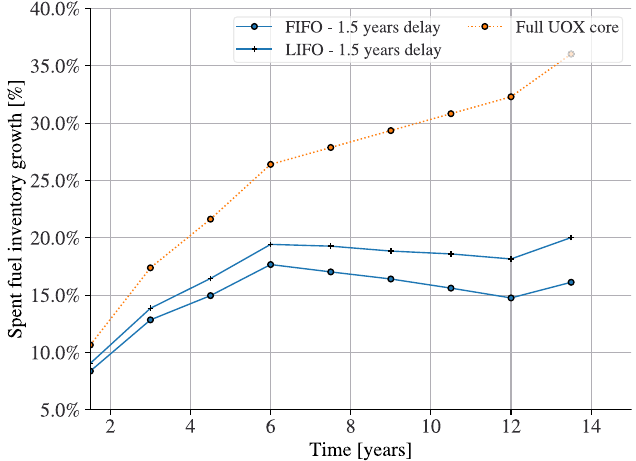
Fig. 11. On-site spent fuel inventory for different transition strategies after a phase-out of a nuclear reactor fleet as a function of time passed since the reference date t 0